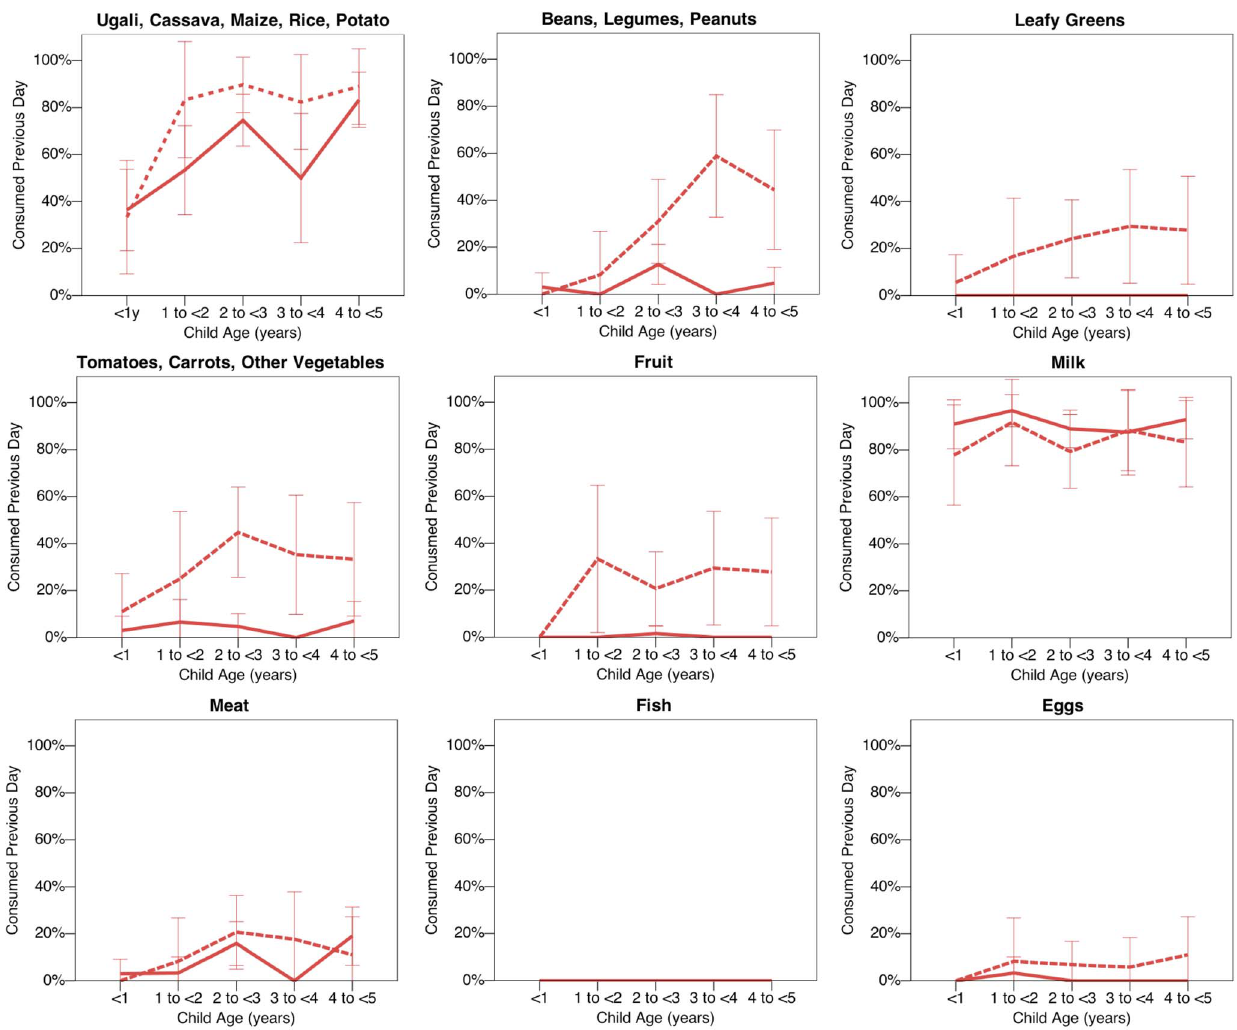
Figure5. Child Diet by Age for Pastoralist and Farming Maasai Households. Maasai child diets differ depending on livelihood. Red solid line = Maasai pastoralist children; red dashed line = Maasai farming children. Data plotted only for the 7 villages containing Maasai households sampled outside of the hunger season (n=298 children). 95% confidence intervals calculated using normal approximation. See File S5 for multilevel logistic regression models predicting food consumption for all Maasai children adjusted for child age, child sex, hunger season and a random effect for village.